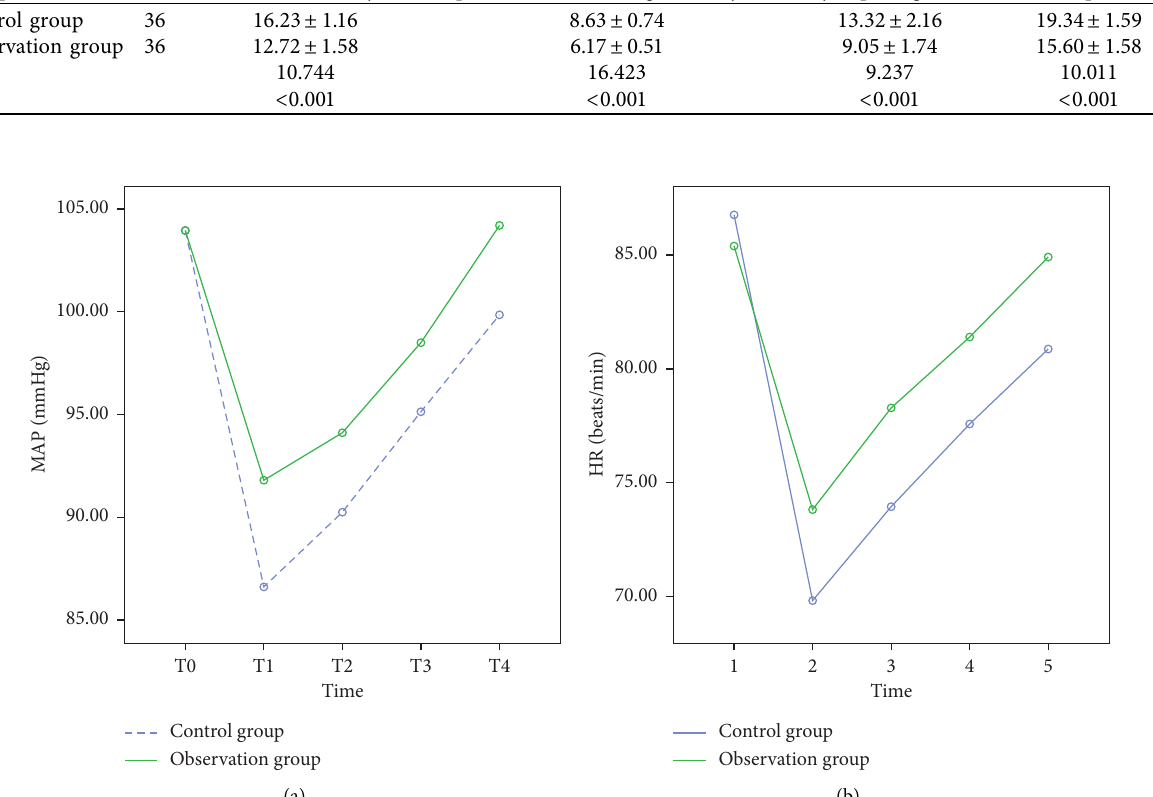
Table 1: Te indexes related to the anesthesia efect of the two groups ( x ± s , min). Group